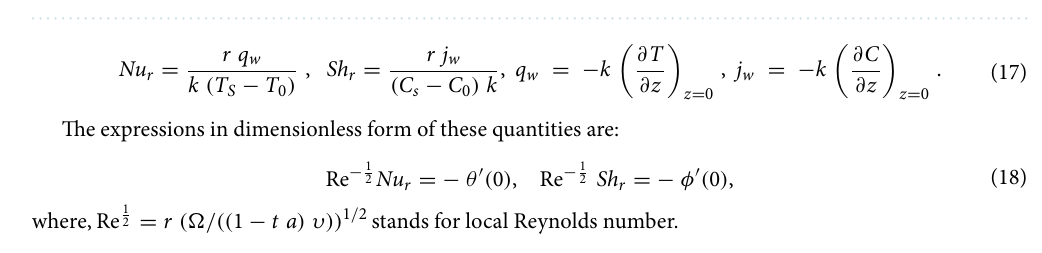
Figure 3. Work flow diagram of NNs- BLMS for